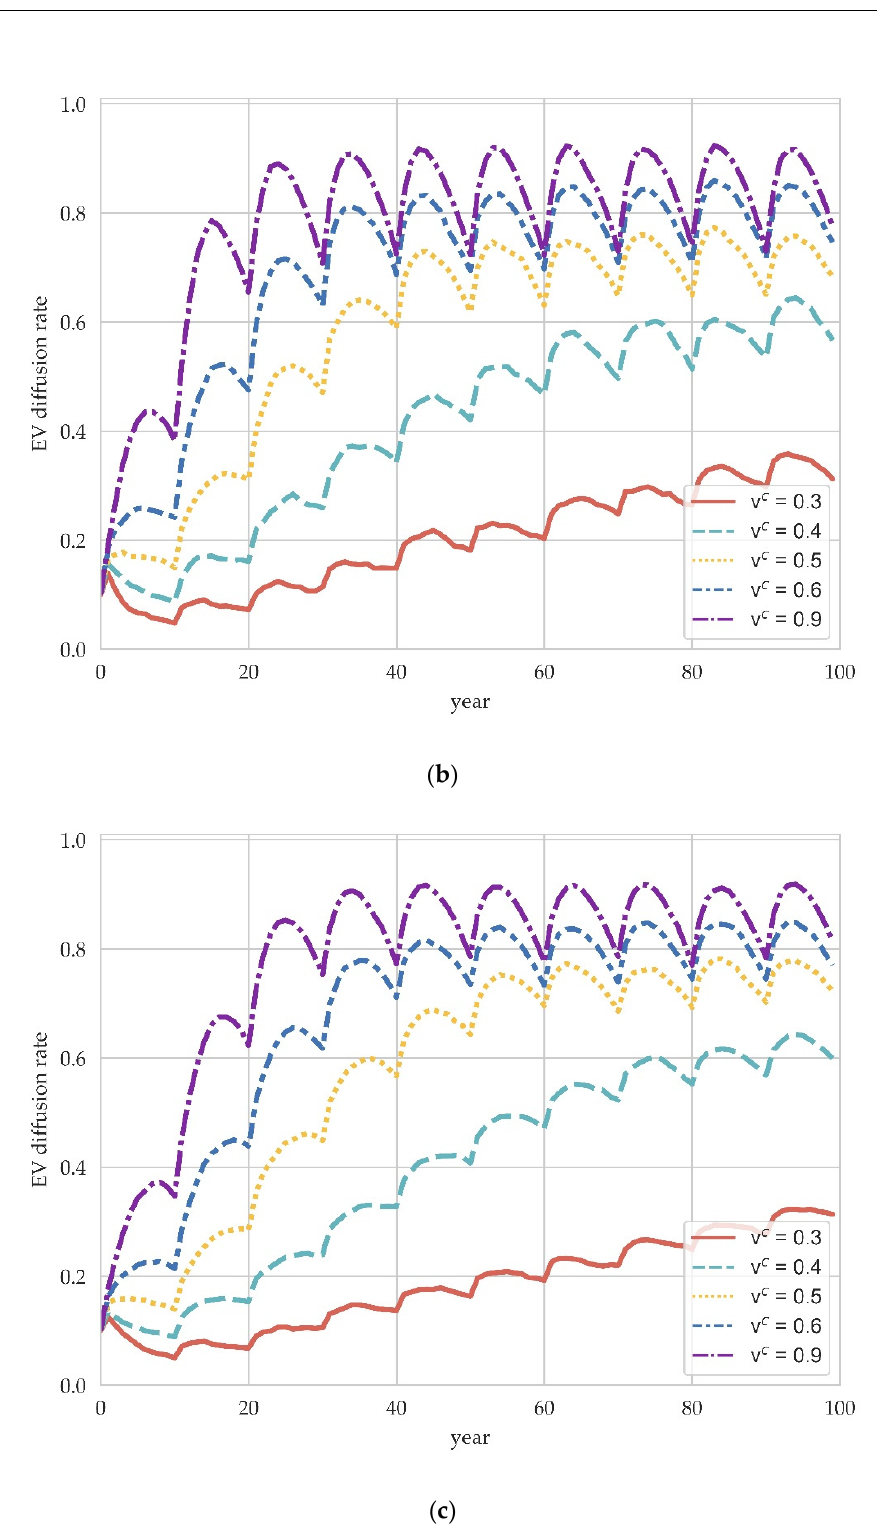
Figure 5. The impact of purchase subsidy policy on EV diffusion in different scale network. ( a ) 𝑀 = 100 . ( b ) 𝑀 = 200 . ( c ) 𝑀 = 300 .